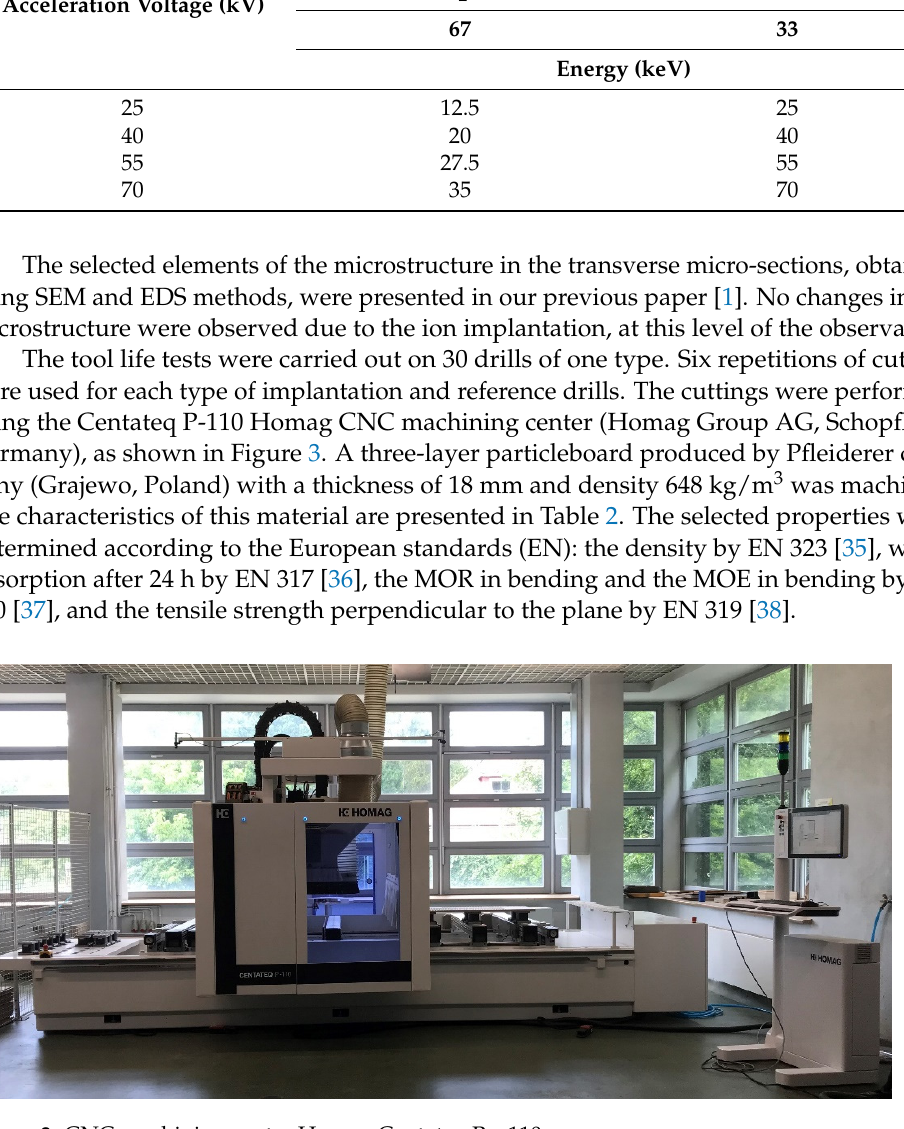
Figure 3. CNC machining center Homag Centateq P—110. Table 2. Selected mechanical and physical properties of the tested three-layer